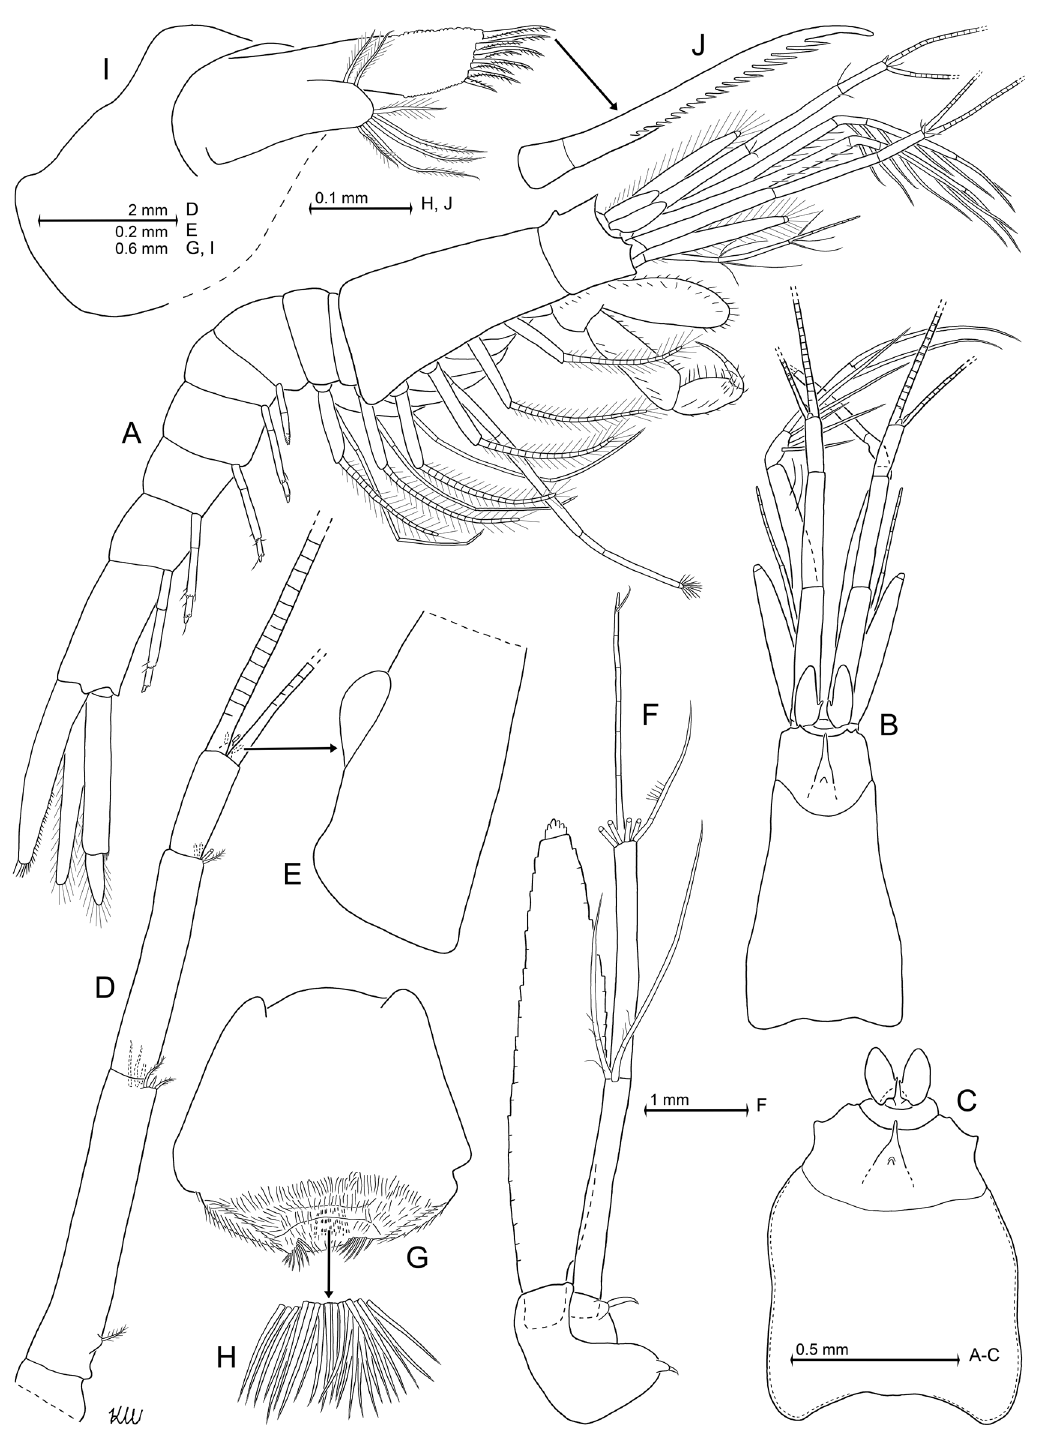
Fig. 1. Petalophthalmus cristatus sp. nov., holotype, adult female with body length 28.3 mm (ZMH 58247). A . Habitus. B . Anterior body region, dorsal (most setae omitted). C . Carapace with attached frons, ocular symphysis and eyes, expanded on slide. D . Antennula, ventral. E . Detail of D, below drawing plane (showing basis of outer flagellum). F . Antenna, ventral (setae of scale omitted). G . Labrum. H . Detail of G, below drawing plane (showing spine bunch from posterior face). I . Maxillula. J . Detail of I, showing serrated